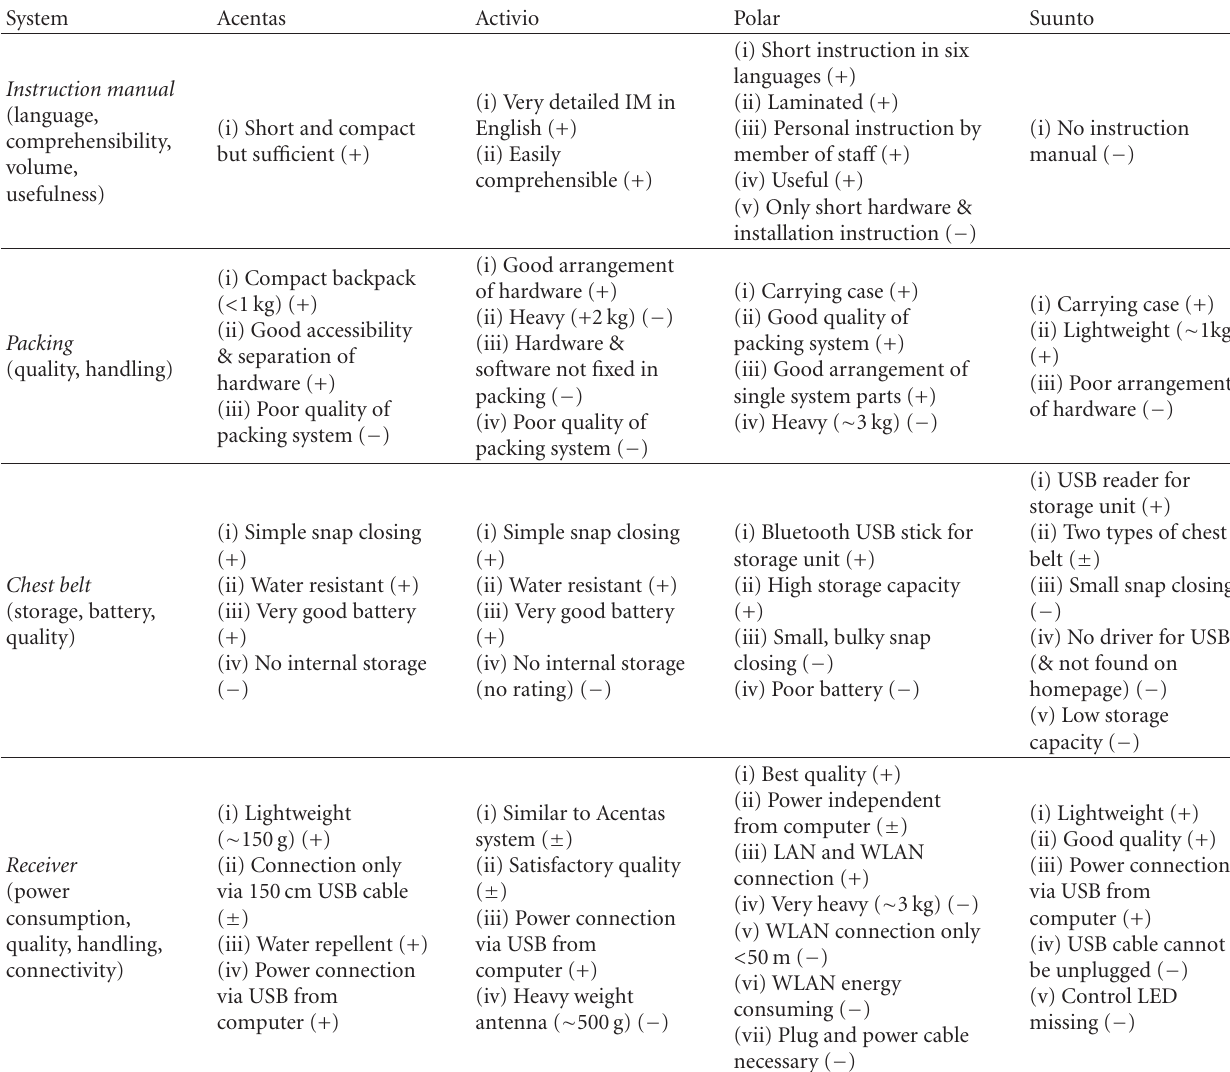
Table 2: Notes on hardware comparison.